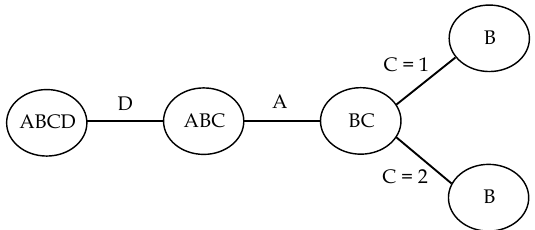
Figure A7. Tree graph for the analysis of the effect of factor B on the expected accuracy performance.